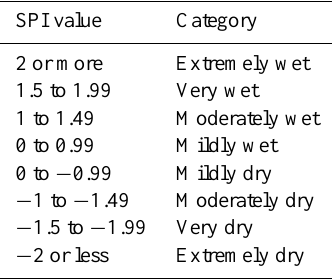
Table 1. Thresholds of SPI for drought